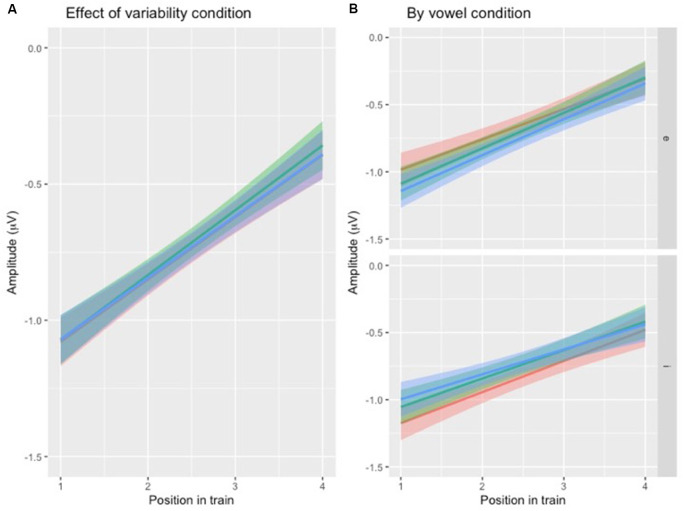
(A) Illustration of N1 repetition-attenuation as a function of variability condition (red = no, green = low, blue = high). Note that all three variability conditions are included in the plot but that lines overlap, potentially making them hard to distinguish. (B) Illustration of N1 repetition-attenuation as a function of variability condition (red = no, green = low, blue = high) by vowel condition.